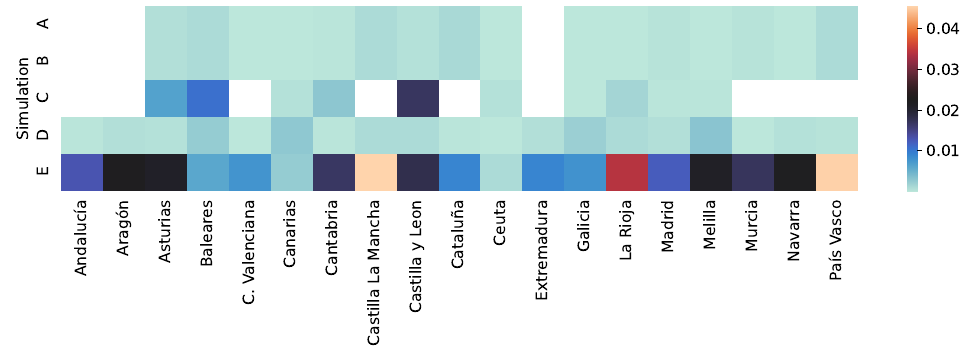
Figure 4. RSME values for the numerical simulations per Autonomous